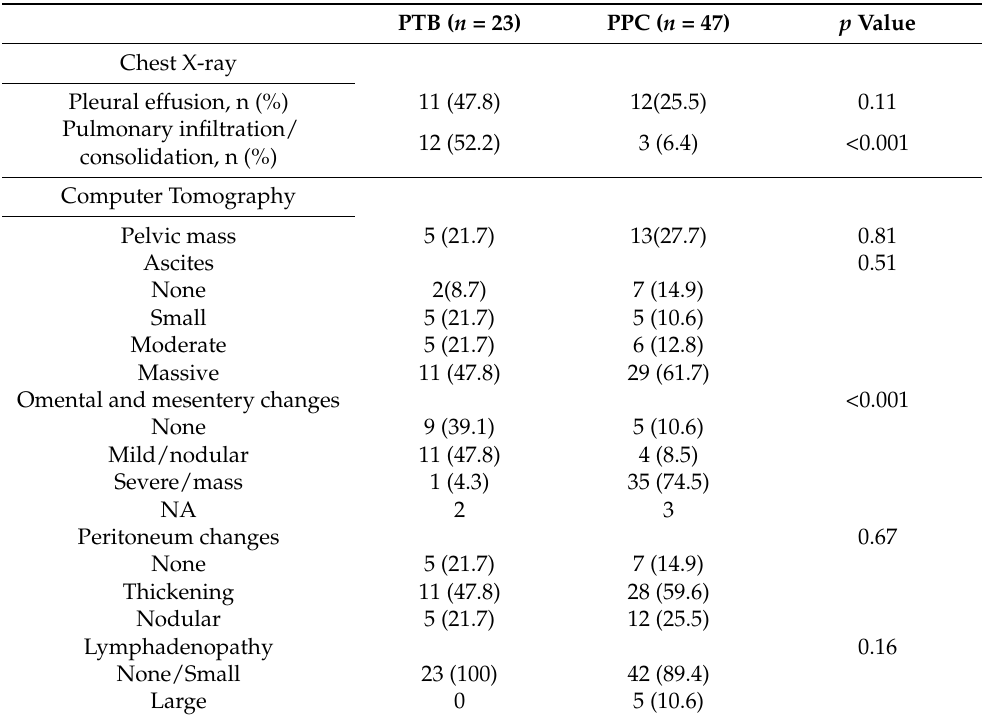
Table 2. Radiographic characteristics.